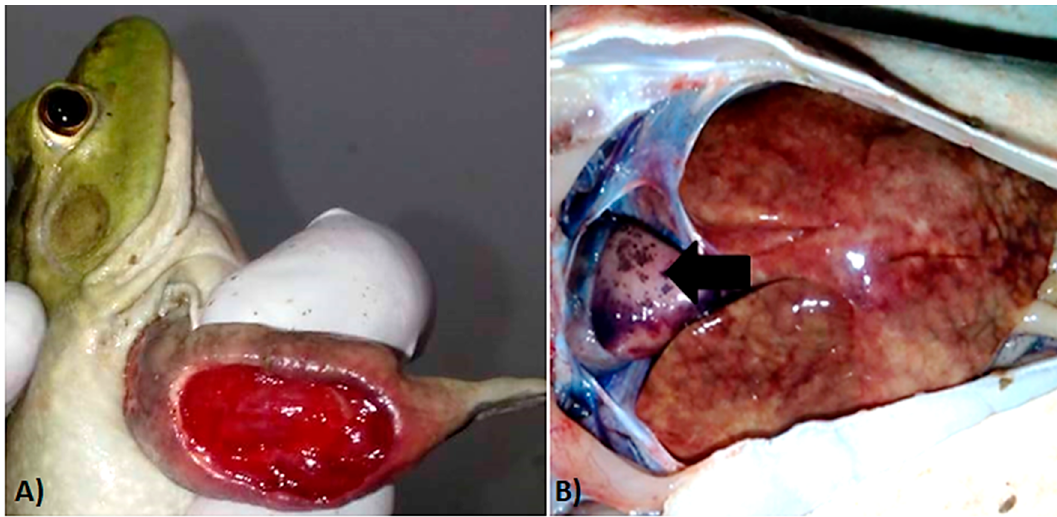
Figure 2. Macroscopic lesions of ranavirus-infected bullfrogs. ( A ) Extensive ulceration of the forelimb. ( B ) Extensive hepatic necrosis and epicardial pallor and hemorrhages (black arrow).